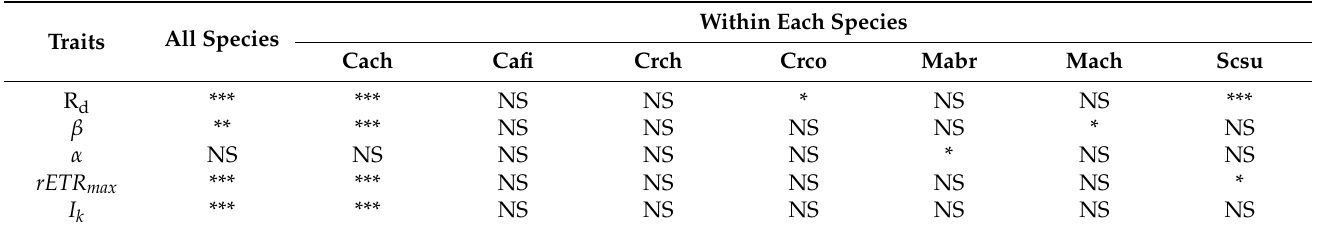
Table A6. The results of one-way analysis of variance (ANOVA) of functional trait differences among different parts of the tree crown in all species and within each species.